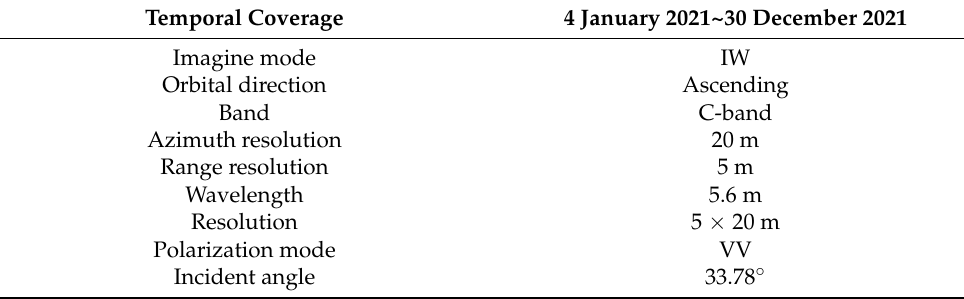
Table 1. Basic parameters of the Sentinel-1A data for the study